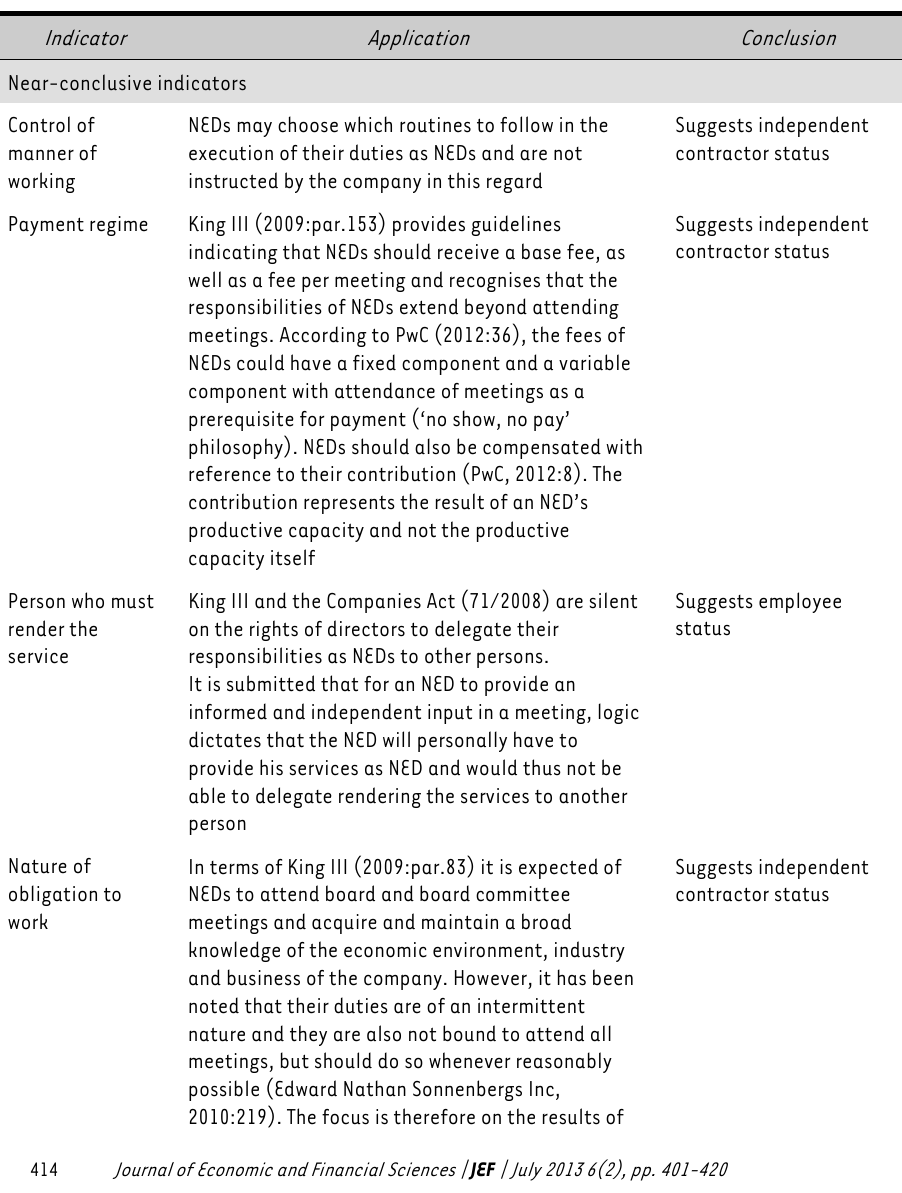
TABLE 4: Common law dominant impression test